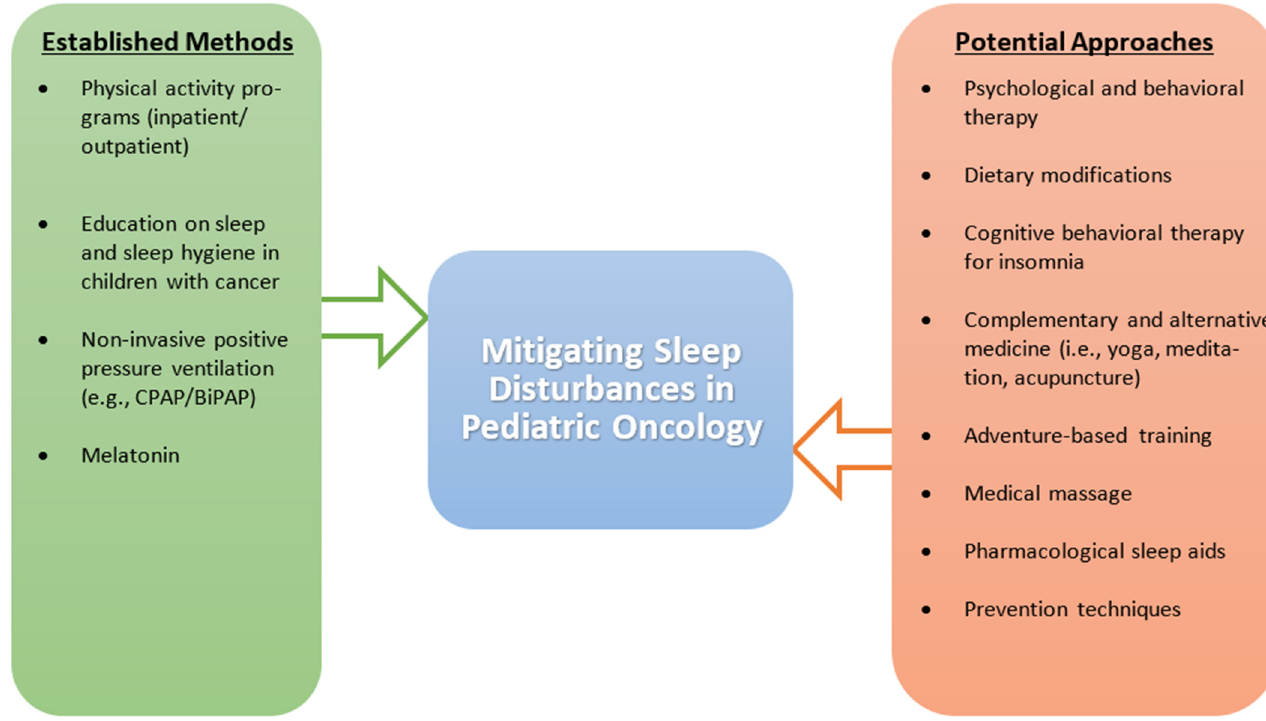
Figure 2. Established and potential management strategies to address sleep disturbances in pediatric cancer patients. The figure compares established methods that have been found to positively impact sleep to potential methods that require more investigation, specifically in the pediatric cancer population. Abbreviations: BiPAP, bi-level positive airway pressure; CPAP, continuous positive airway pressure.